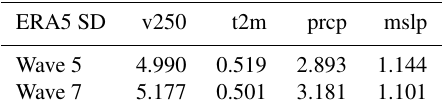
Table A5. Summary of ERA5 standard deviation values.